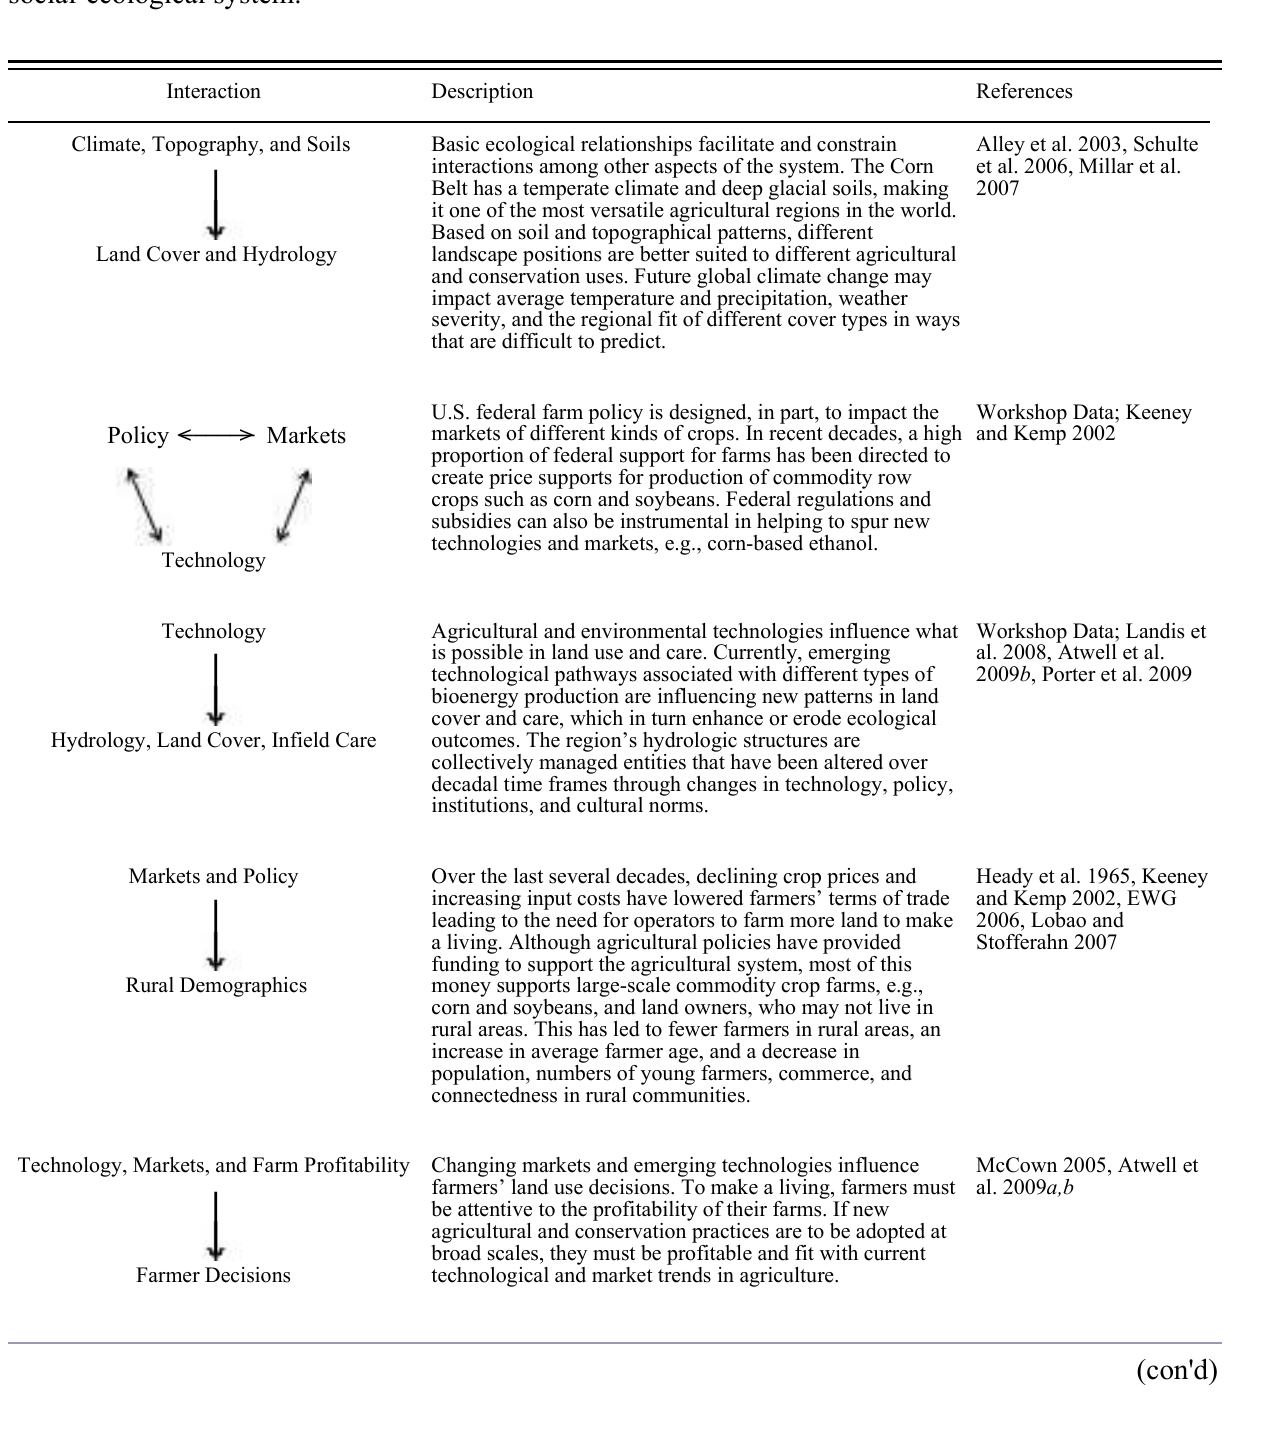
Table 2. The relationships among different drivers and outcomes (Fig. 1) of land use in the Corn Belt social-ecological